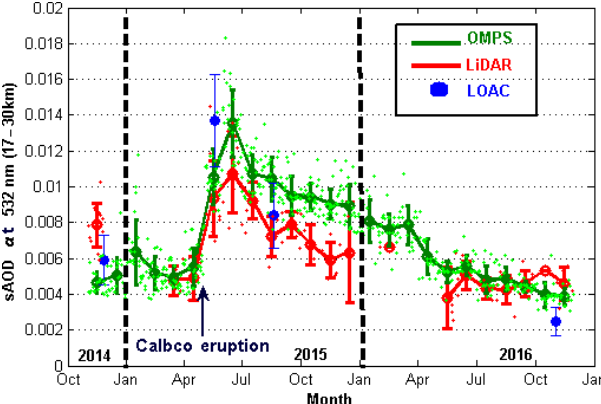
Figure 6. Evolution of SAOD calculated between 17 and 30km at 532nm from lidar (red), LOAC OPC (blue), and OMPS (green) ob- servations between November 2014 and November 2016 over the Reunion site. The small dots represent the daily SAOD and the large dots represent the monthly averaged SAOD obtained from OMPS and lidar observations. The large blue dots represent the SAOD cal- culated from LOAC OPC observations over Reunion on 26 Novem- ber 2014, 19 May 2015, 19 August 2015, and 2 November 2016. The error bars associated with lidar and OMPS observations rep- resent the standard deviation. The error bars associated with LOAC OPC represent the uncertainty values. The date of the Calbuco erup- tion is indicated by a blue